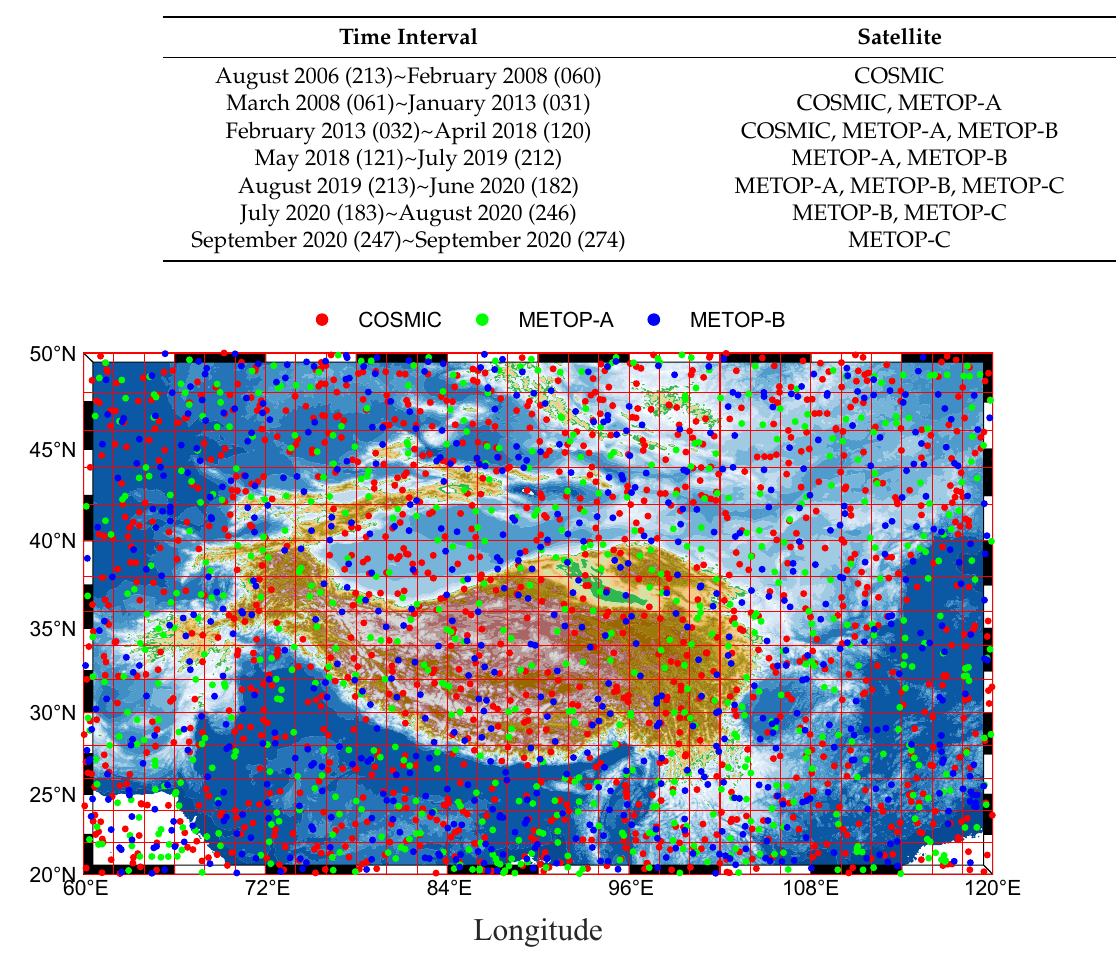
Table 1. The selected RO missions in each time interval around TP from August 2006 to September